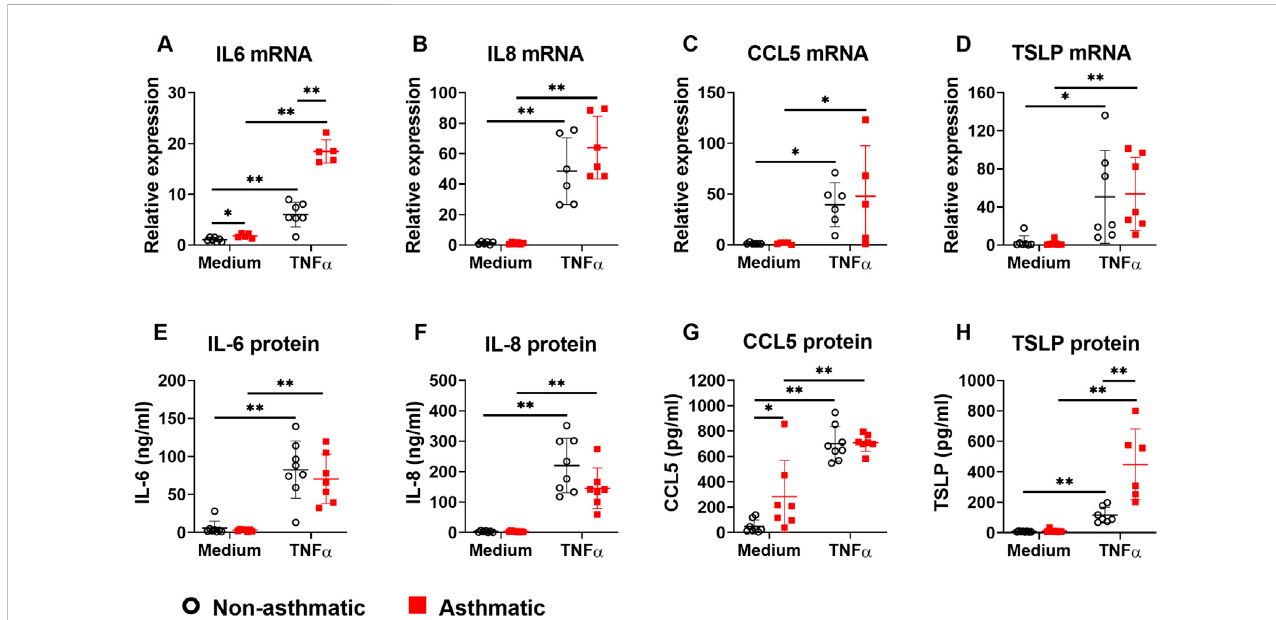
FIGURE 1 The expression of proin fl ammatory cytokines/chemokines in asthmatic and non-asthmatic human lung fi broblasts. Serum-starved fi broblasts were culturedwithmediumorTNF α (20 ng/ml)for24 hor3 days.RNAwasextracted fromthecellsculturedfor24 h.Culturesupernatantswereharvestedafter3- dayculture.GeneexpressionwasdeterminedbyquantitativePCR (A – D) .Thelevelsofcytokines/chemokinesintheculturesupernatantsweredeterminedby ELISA (E – H) . Data are shown as mean ± SD from N = 5 – 9 patient samples. Each dot represents one patient sample. * indicates signi fi cant difference p < 0.05. ** indicates signi fi cant difference p < 0.01.